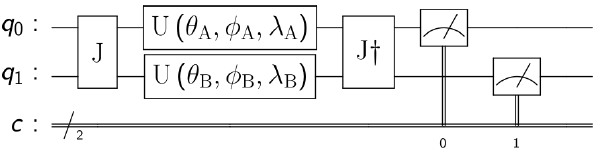
Figure 2. EWL game model for 2 players. Where q 0 and q 1 are the initial quantum states of the players and c is a classical register where the qubits measurements are